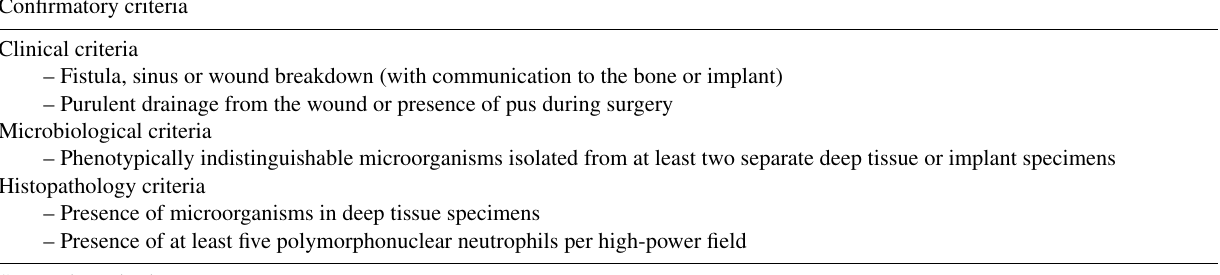
Table 1. Diagnostic criteria for fracture-related infections (Metsemakers et al., 2018b; Govaert et al.,